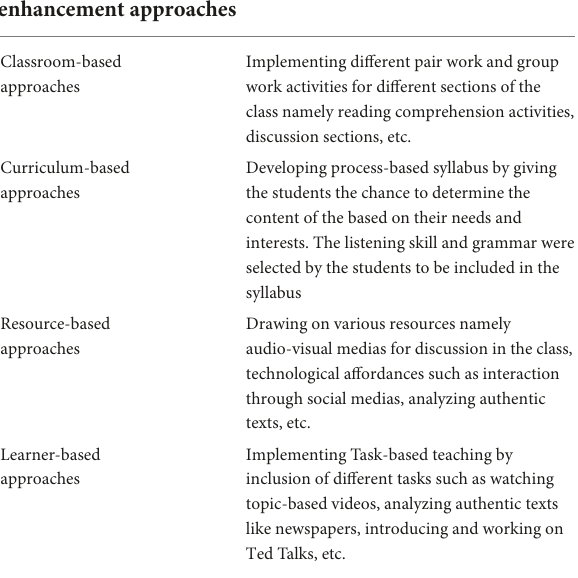
TABLE 1 Summary of autonomy-enhancement